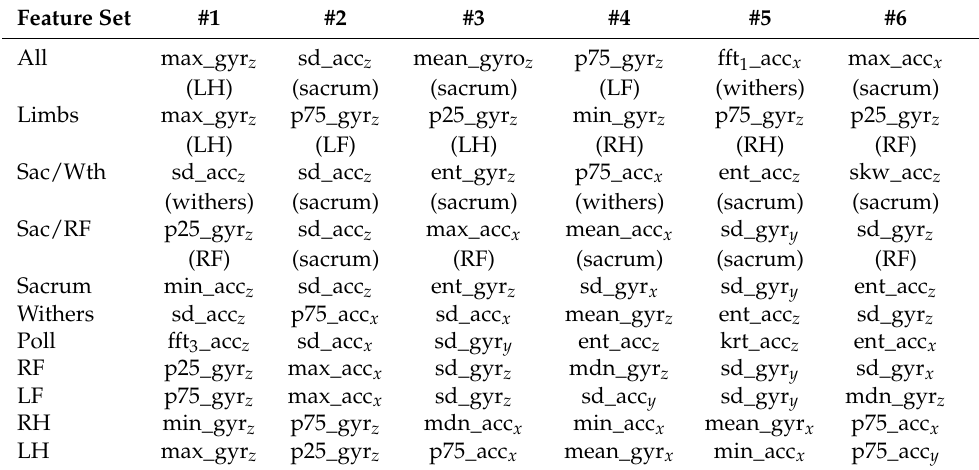
Table 4. The highest ranked (first to sixth) selected features using SFFS based on random forest method.